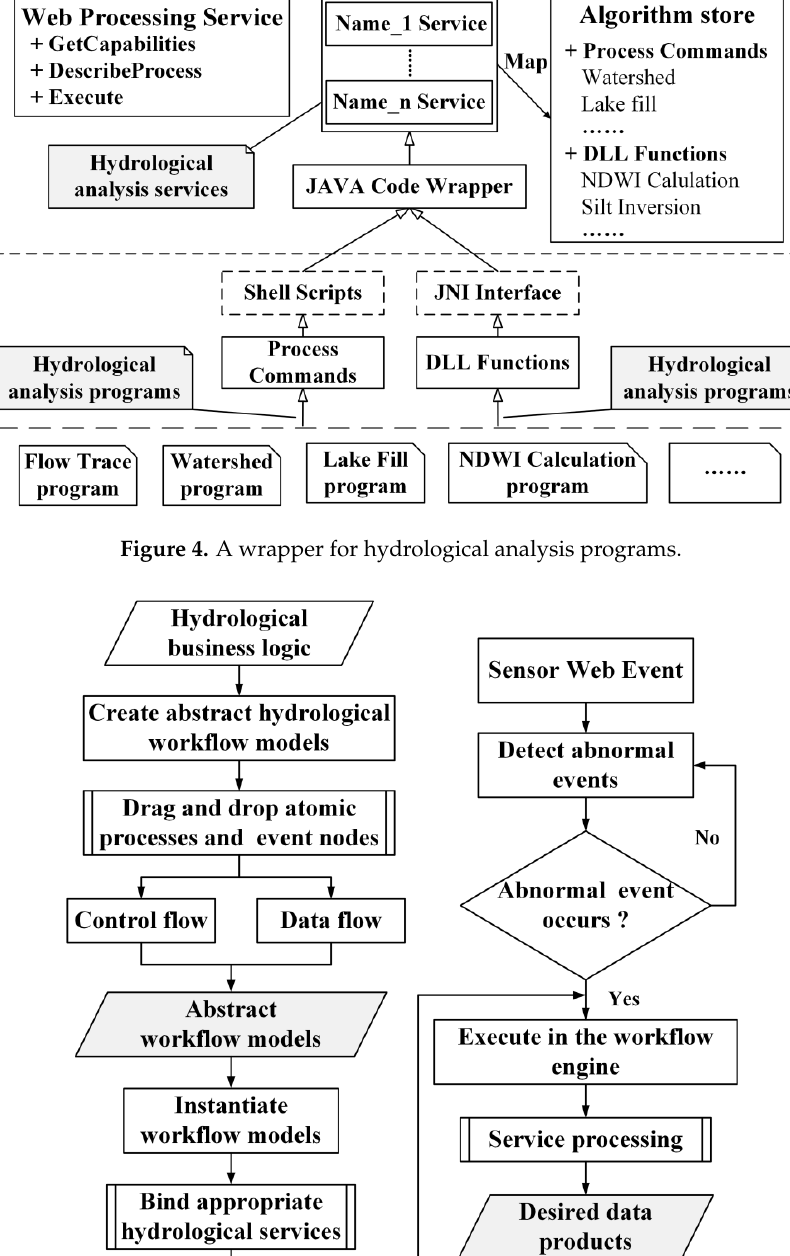
ISPRS Int. J. Geo-Inf. 2016 , 5 , 171 10 of 22